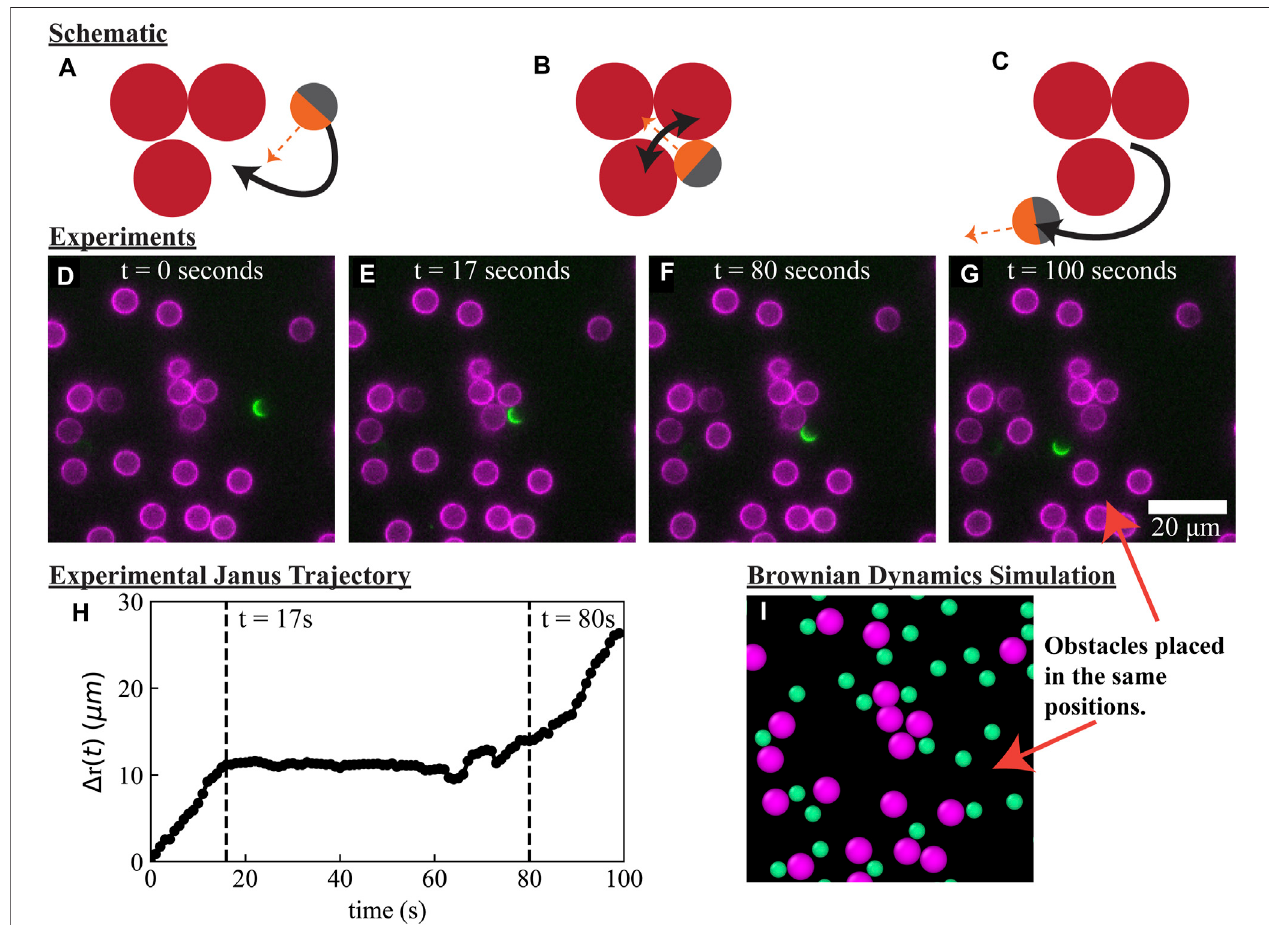
FIGURE1| Activeparticlesexperienceasigni fi cantslowdownnearobstacleboundariesand areduction ineffectivediffusivityinarandomarrayof fi xed obstacles. (A – C) : Schematic demonstrating the obstructed motion of an active particle near a grouping of three obstacles. (D – G) : Experimental images of a 4 μ m Janus particle (green semicircle) moving through 6.5 μ m obstacle particles (magenta). (H) Displacement of the active Janus particle (green semicircle) tracked for 100 s. (I) Brownian Dynamics(BD)simulation snapshotofactiveBrownian particlesmoving througharecreatedcopyofthesameporousmediaasintheexperiments.Moreindividual particle trajectories are available in the Supplementary Information ( Supplementary Figure S1